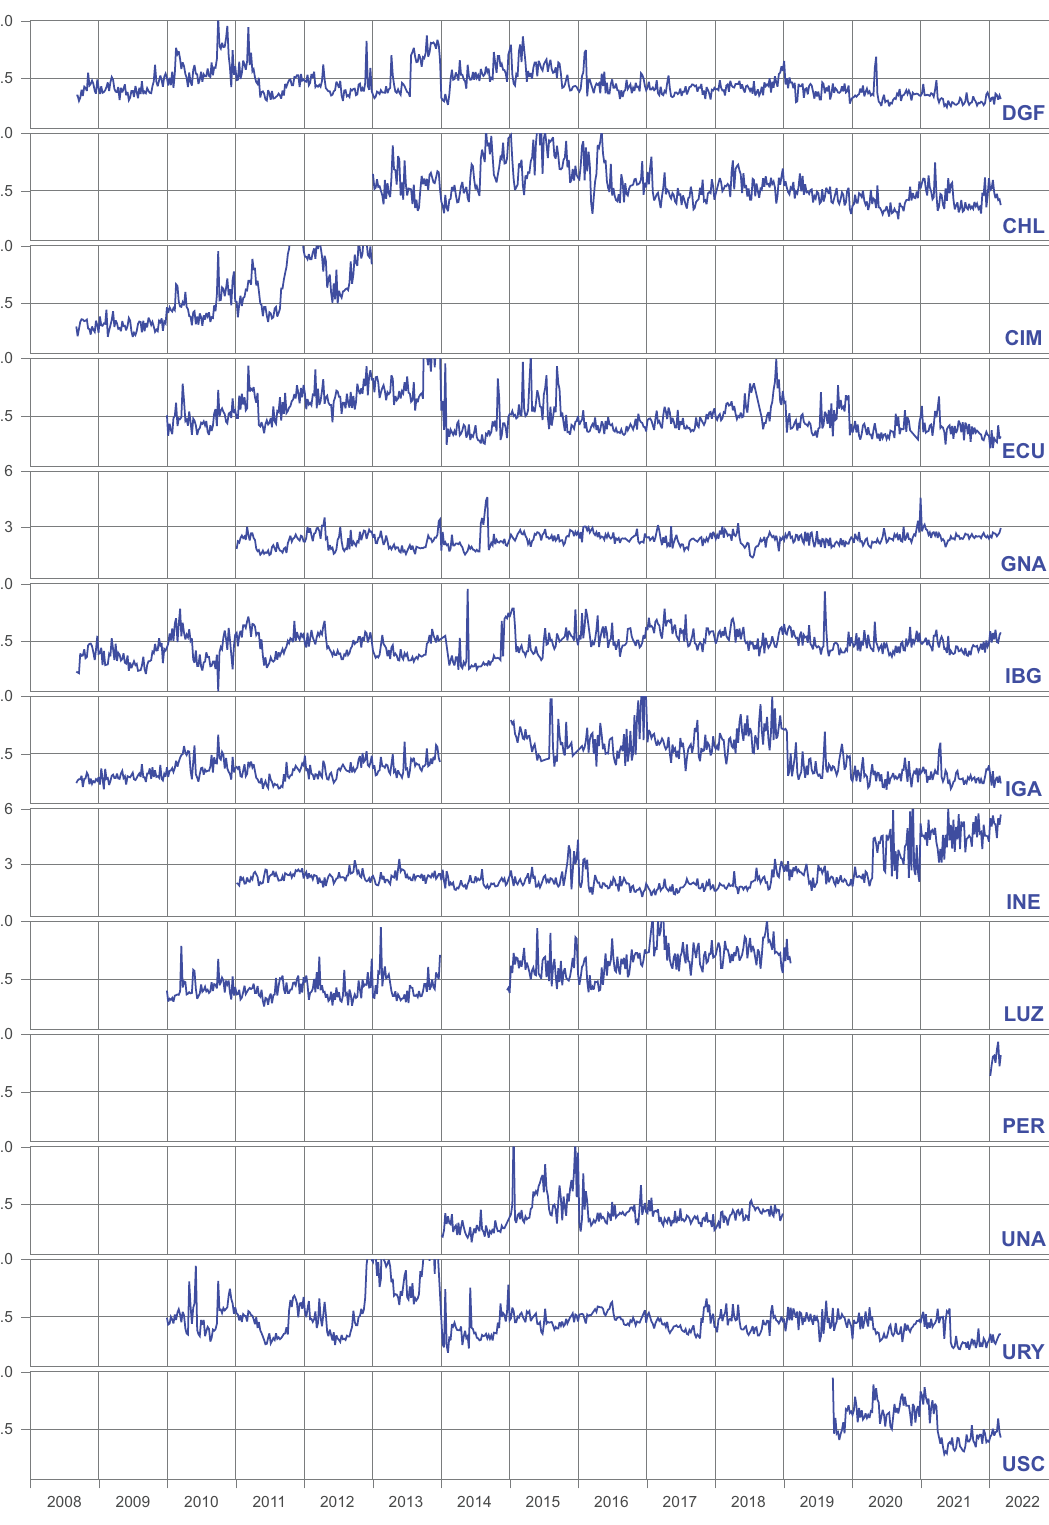
Figure 5: RMS values of a seven - parameter transformation between the individual solutions delivered by the SIRGAS analysis centres and the SIRGAS weekly combination ( see Table 1 for more details about the SIRGAS analysis centres )